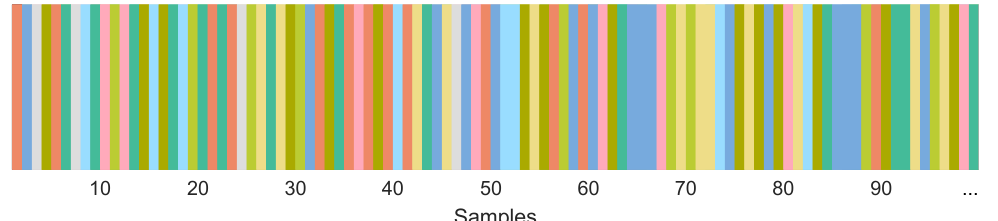
Figure 10. The order of the first 100 training samples. Each color indicates the target velocity range as shown in Figure 4.